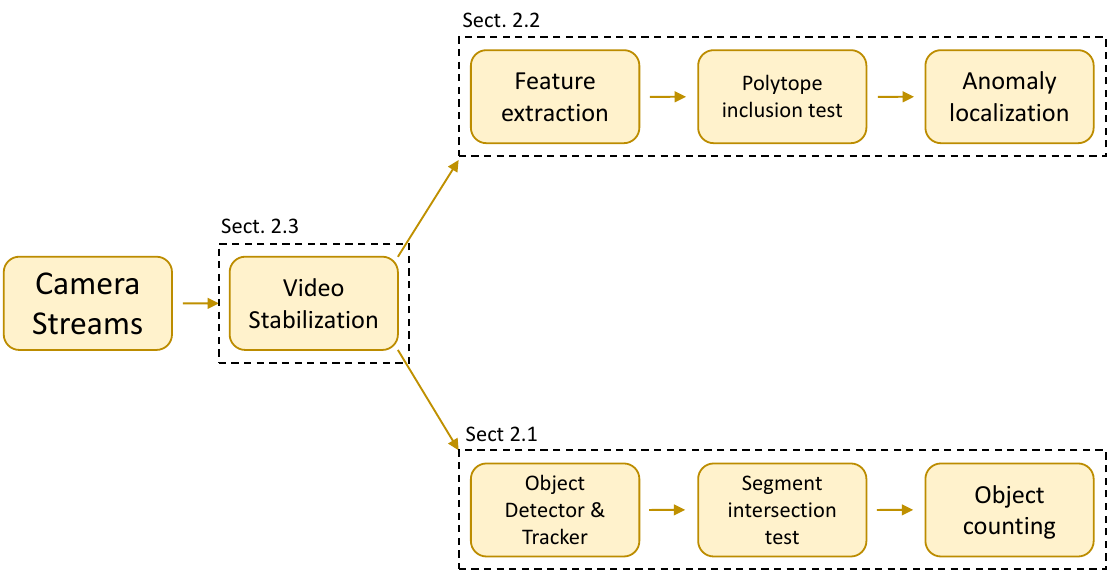
Figure 2. Scheme of our surveillance system. For each algorithm block, we report paper sections